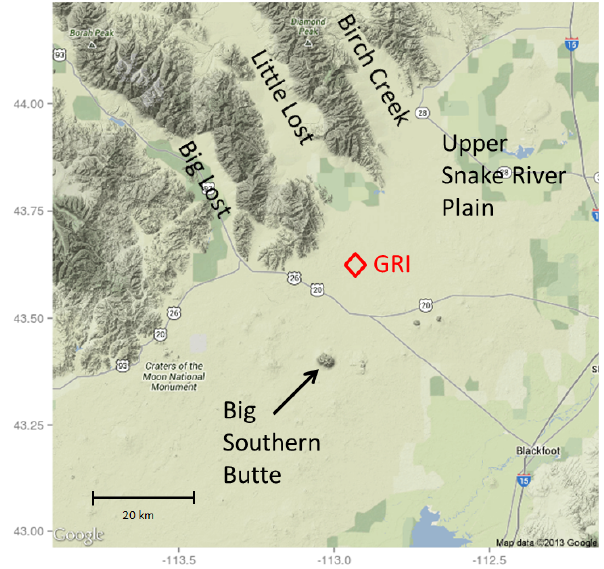
Figure 2. Snake River Plain and prominent drainages surrounding the Big Southern Butte study site. Red diamond indicates the GRI mesonet